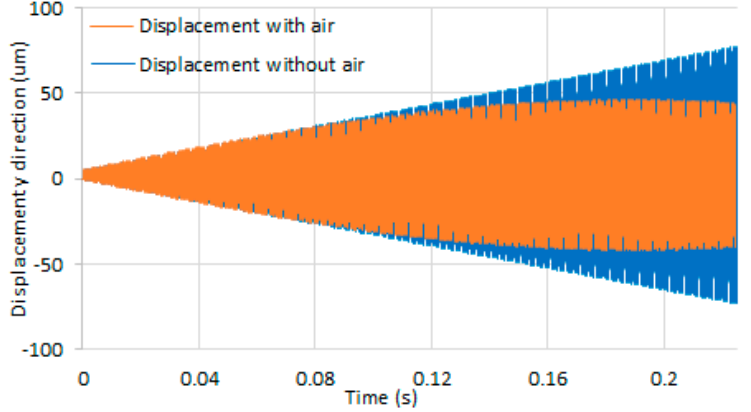
Figure 6. Resonance time response of the cantilever fiber measured at the tip, with the damping effect of surrounding air versus no damping.